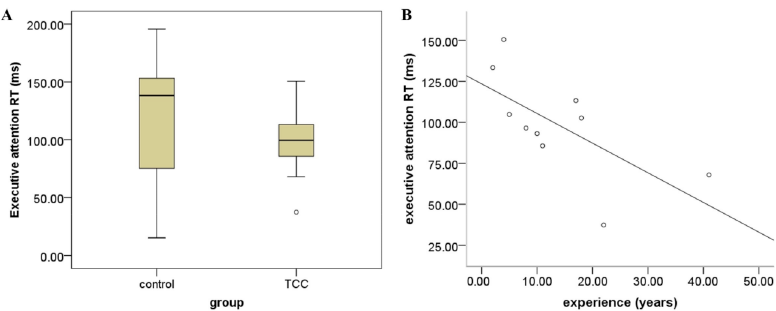
Figure 2. Results of behavior performance. ( A ) RT of ANT comparison ( B ) correlation between TCC experience (years) and RT of ANT. Reprinted with permission from Ref. [30].